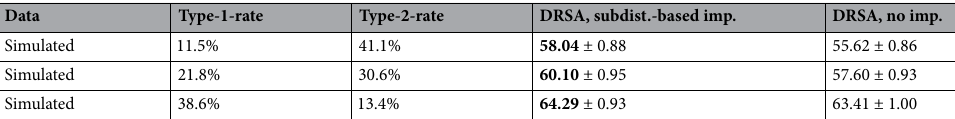
Table 3. Mean estimated C -indices (averaged over time) with estimated standard deviations, as obtained from training the DRSA architecture on the simulated data. The first column on the right-hand side contains results from DRSA architecture trained with the preprocessed input data; The second column shows the results from the DRSA architecture, trained on the original input data (treating individuals with observed competing events as censored individuals). Best-performing methods are marked bold. Note that the C -indices must be compared within each row, as the datasets used for training are different in terms of censoring and event rates across the rows. The numbers in this table are obtained from the test